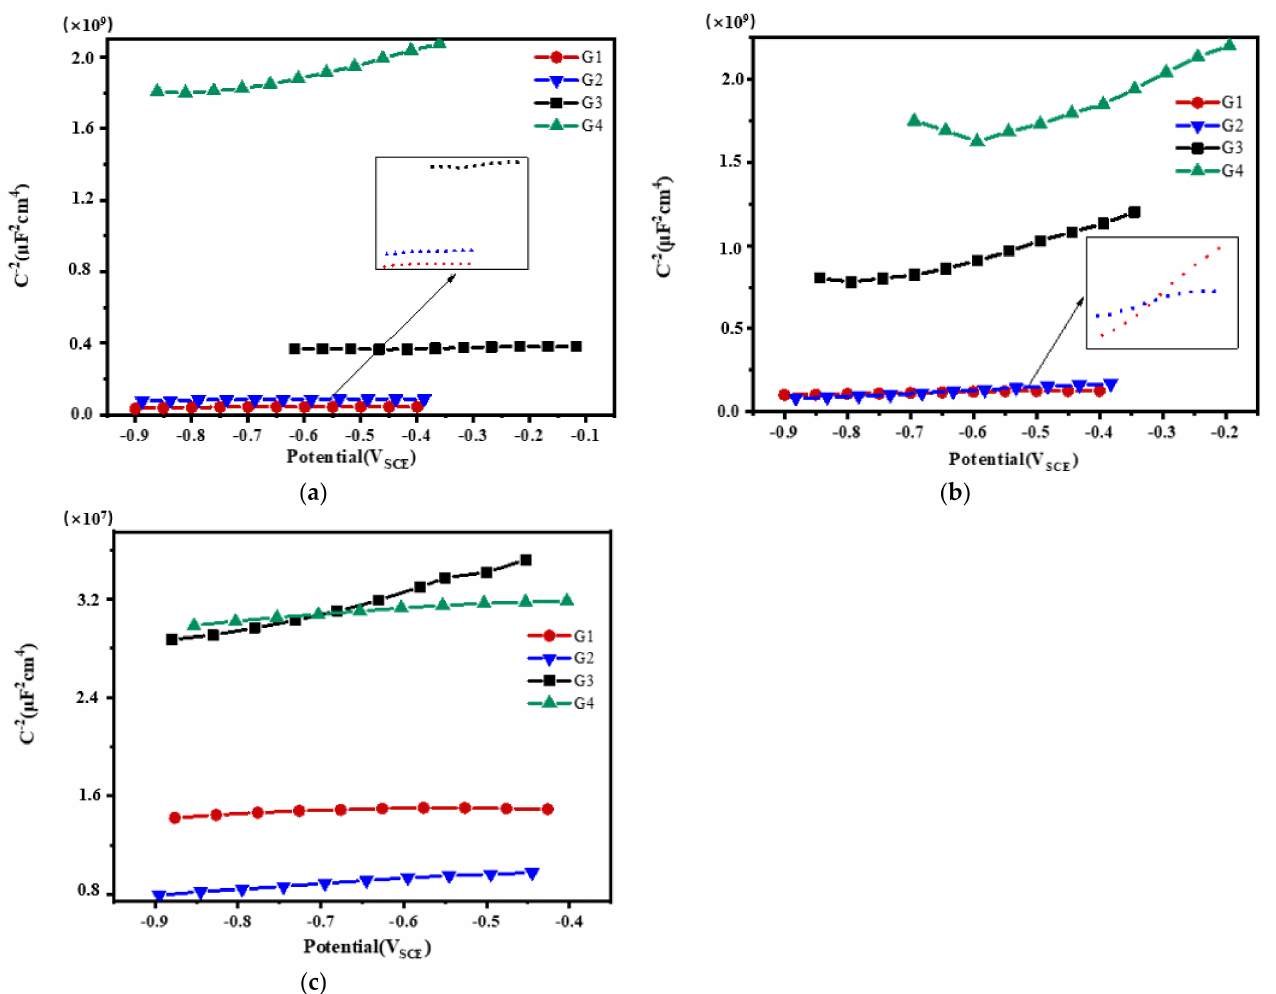
Figure 15. Each coating’s Mott–Schottky pattern for immersion for 60 days: ( a ) 20% Seawater; ( b ) 40% Seawater; ( c ) 60%